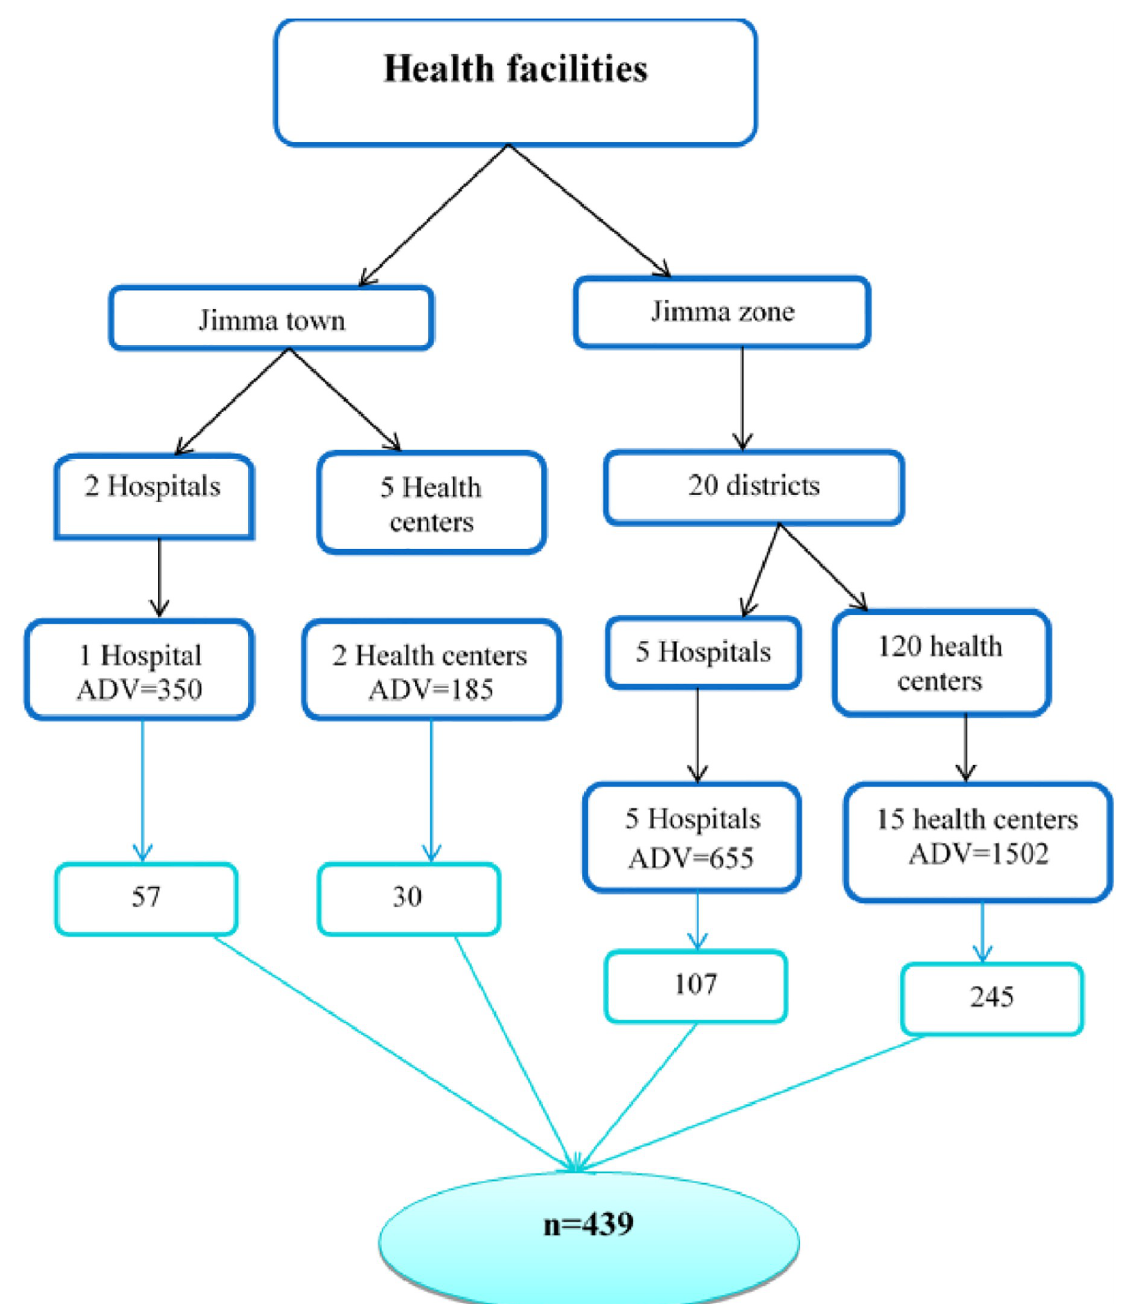
Fig 1. Schematic representation of sampling for health facilities and client, Jimma, August 2020.